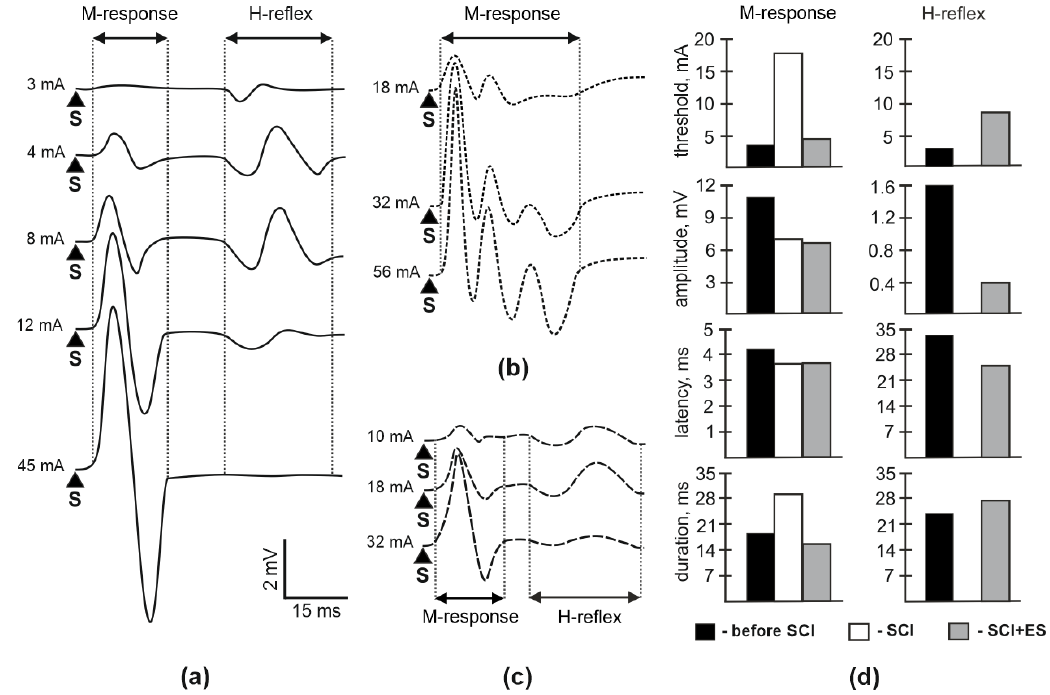
Figure 2. The responses in soleus muscle induced by sciatic nerve stimulation. ( a )—the response of soleus muscle before SCI; ( b )—response of soleus muscle 8 weeks after SCI in SCI group; ( c )—response of soleus muscle 8 weeks after SCI in SCI-ES (electrical stimulation) group; ( d )—comparison between the different parameters of M-response and H-reflex. S—stimulus. Responses in soleus muscle recorded before SCI (before SCI), after SCI (SCI), and in SCI + EES (epidural electrosimulation) group (SCI-EES).